Question: Briefly state, in one sentence, what is plotted here.
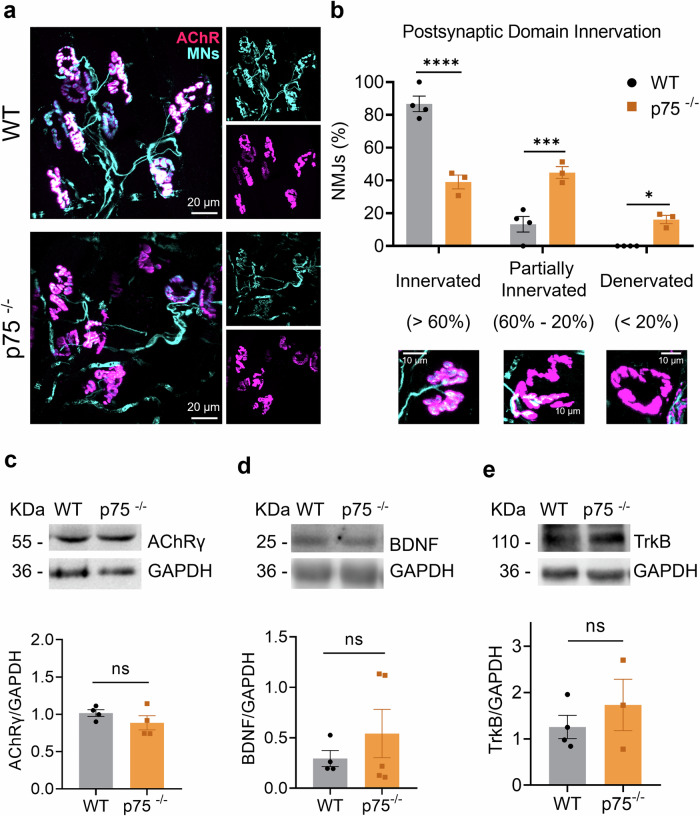
Answer: p75⁻/⁻ mice show enhanced NMJ denervation during aging. Whole-mount lumbrical muscles from aged control and p75⁻/⁻ mice were stained to reveal presynaptic axons (2H3 + SV2 antibodies; cyan) and postsynaptic AChRs (BTX; magenta). a Representative confocal image of NMJs. Scale bar = 20 μm. b NMJ innervation was quantified by the overlap between pre- and postsynaptic areas. Bottom panels show examples of innervated ( > 60%), partially innervated (20–60%), and denervated ( < 20%) NMJs. N = 3-4 mice. Scale bar = 10 μm. Western blot of Gastrocnemius muscle samples from aged control and p75⁻/⁻ mice ( N = 3-5 mice) for the AChR γ-subunit ( c ) BDNF ( d ) and TrkB ( e ). GAPDH served as a loading control. Data are shown as mean ± SEM (bars) and individual values (dots). * p < 0.05, *** p < 0.001, **** p < 0.0001, ns non-significant; Two-way ANOVA ( b ) or Mann-Whitney ( c – e ) tests.